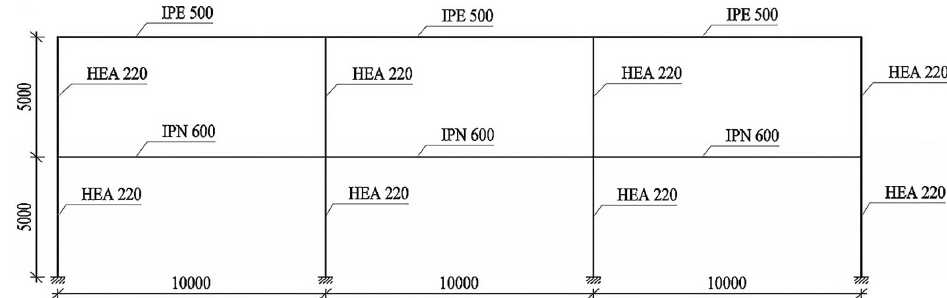
Figure 2. The general scheme of the